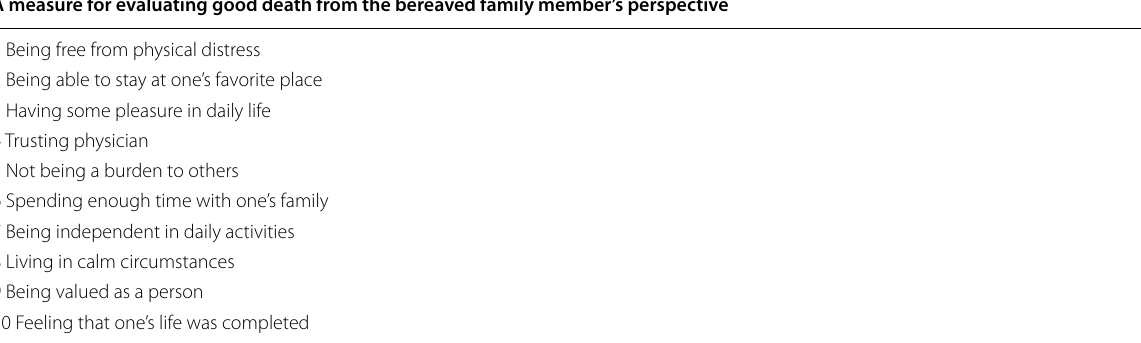
Table 1 The short version of the good death inventory